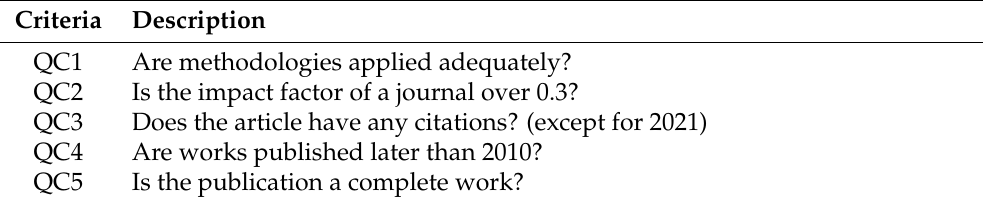
Table 4. Quality